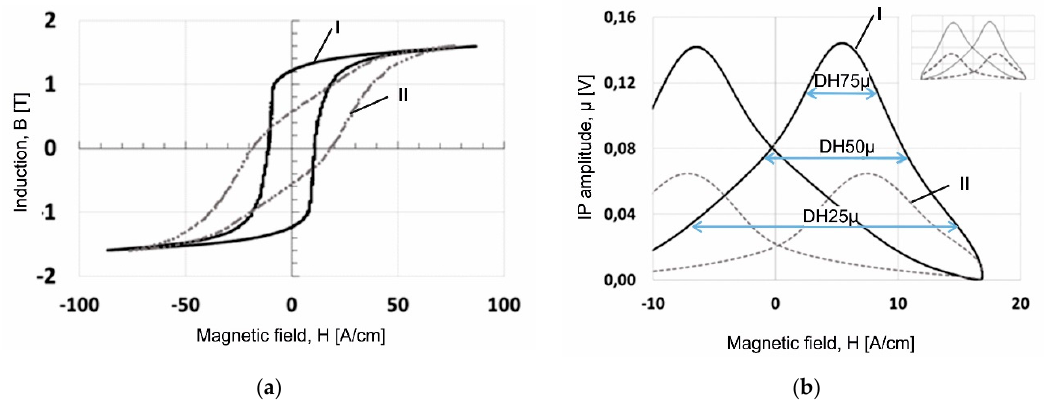
Figure 3. Measurements on a steel sample before (I) and after (II) plastic deformation: ( a ) hysteresis measurements and ( b ) IP measurements. measurements and ( b ) IP